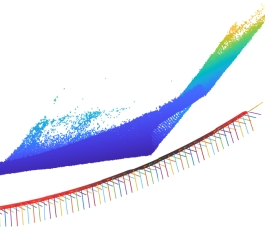
Figure 14. The performance of the non-cutting path velocity planning.